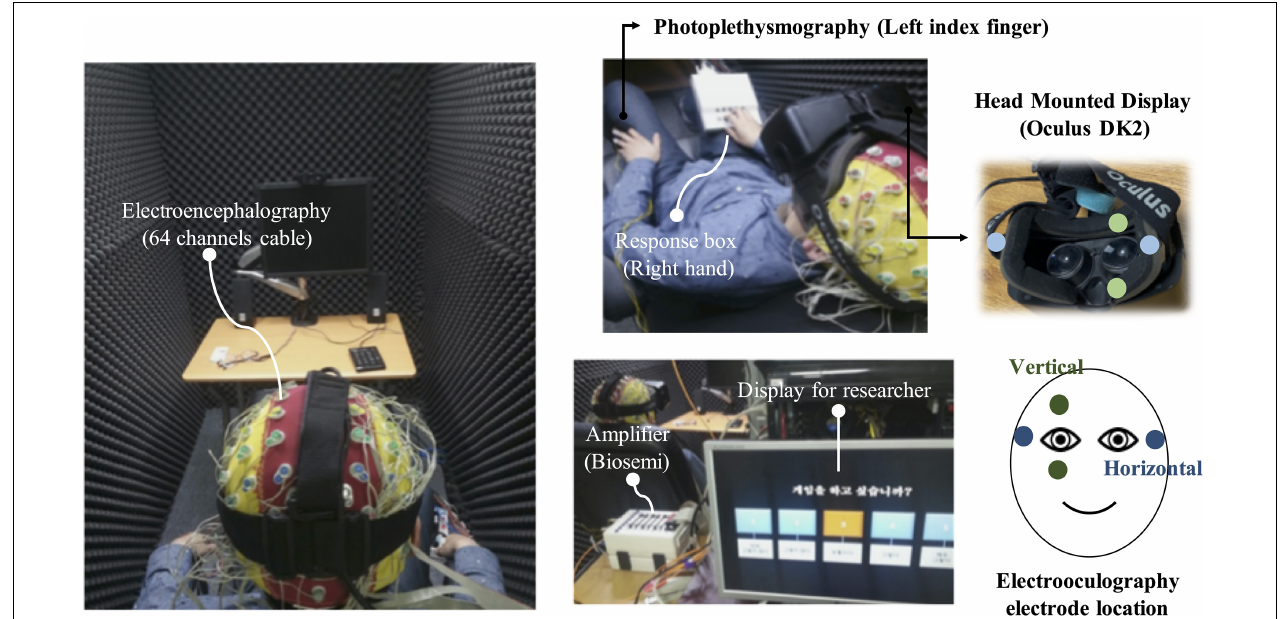
FIGURE 2 | Experimental